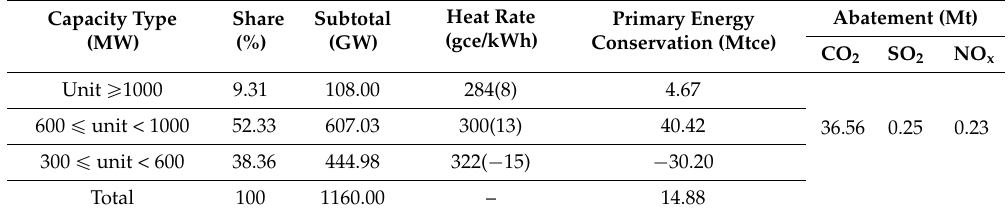
Table 8. Potential by structural adjustment and retrofitting of coal power in